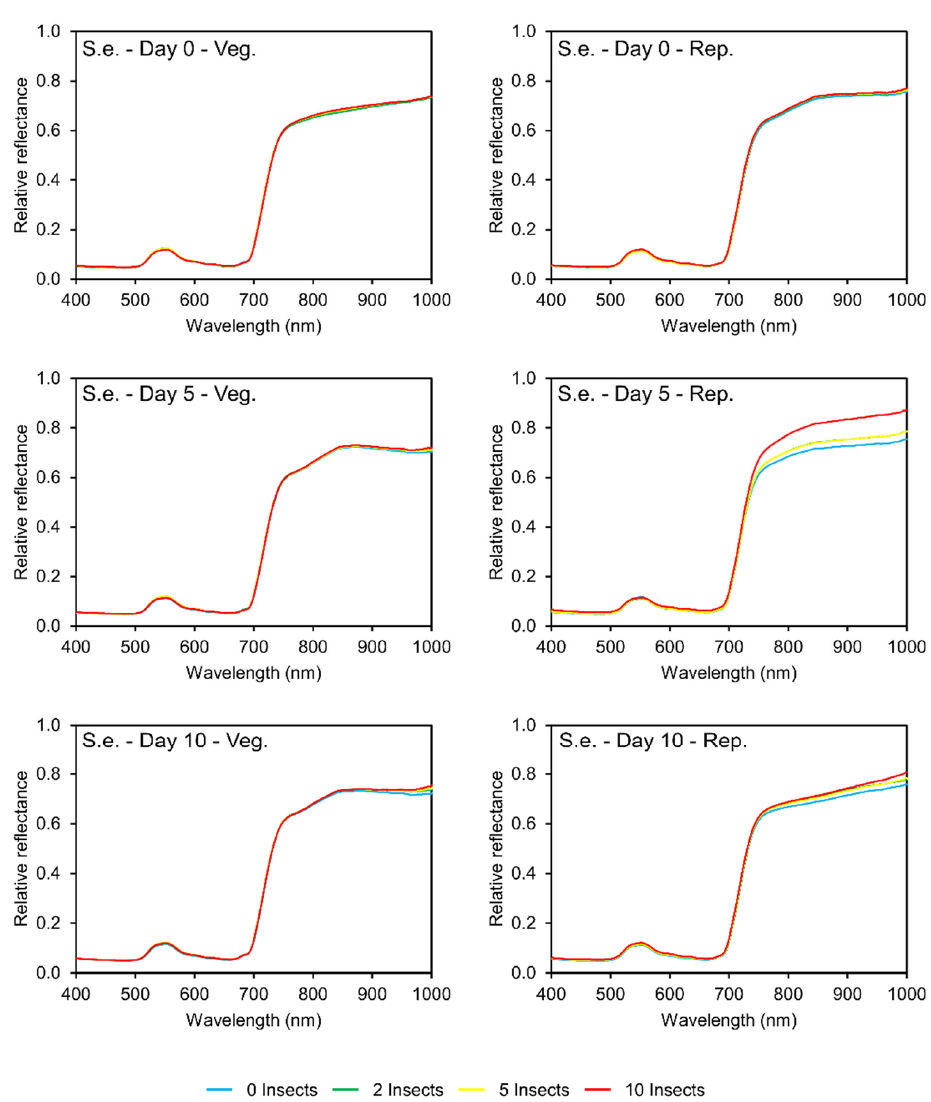
Figure 4. Spectral curves (400–1000 nm) of soybean leaves (0, 5, and 10 days after infestation) from plants under different levels of Spodoptera eridania (S.e.) infestation ( left column —soybean vegetative period; right column —soybean reproductive period).